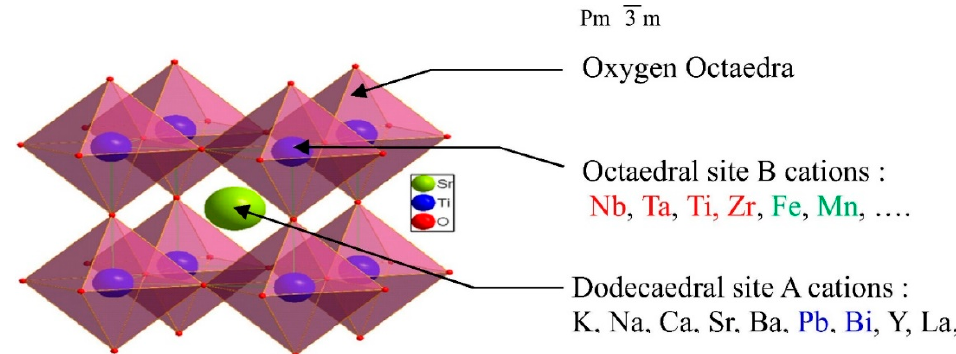
Figure 2. Cubic perovskite SrTiO 3 (Reprinted with permission from [5]).